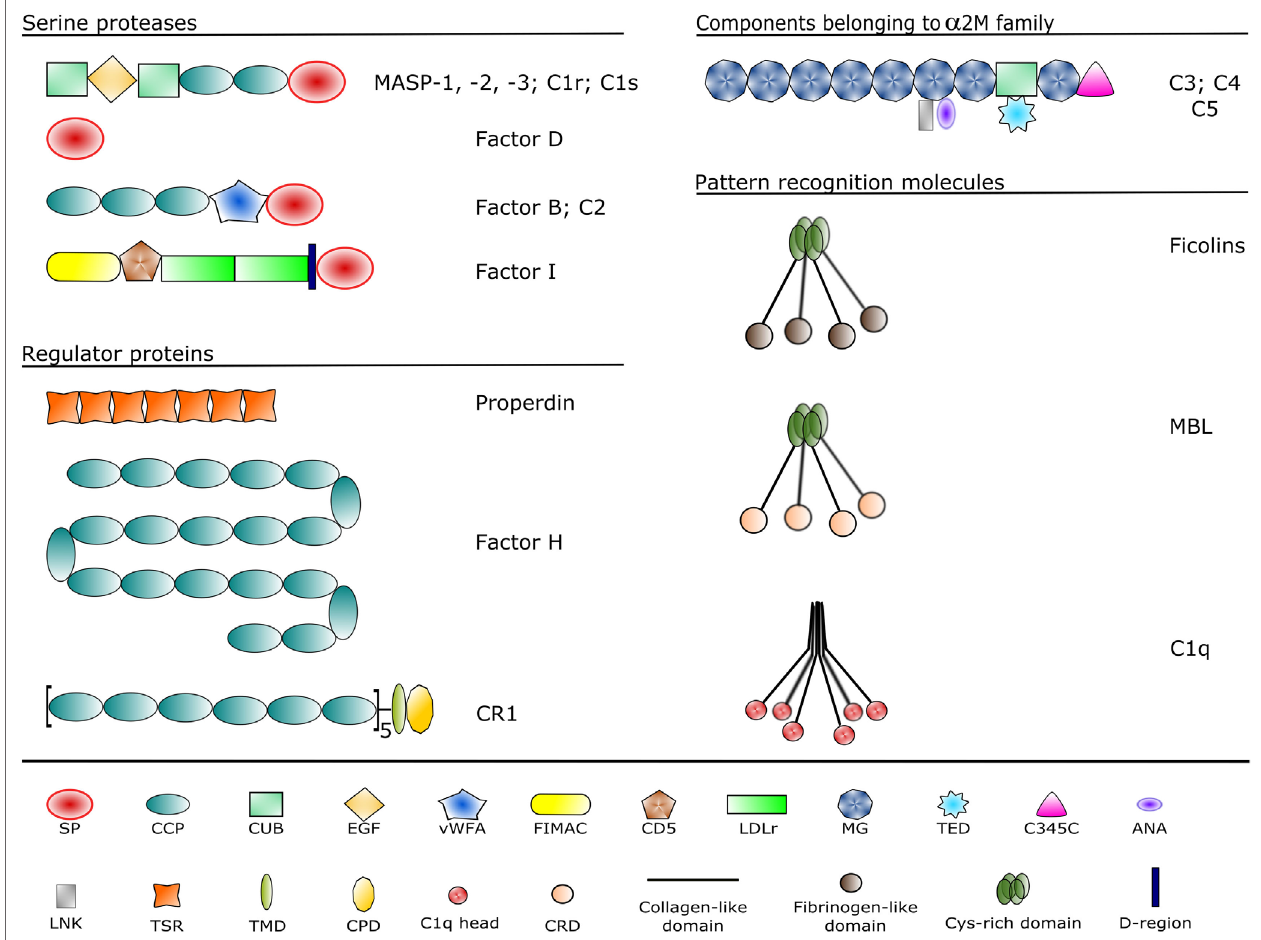
FiGURe 2 | Domain structures of the complement components discussed in the article. Each domain type is represented by a different symbol listed at the bottom. Domain abbreviations are as follows: SP, serine protease; CCP, complement control protein; CUB, complement C1r/C1s, sea urchin Uegf and bone morphogenetic protein-1; EGF, epidermal growth factor-like; vWFA, von Willebrand factor type A; FIMAC, factor I/membrane attack complex; CD5, scavenger receptor cysteine-rich domain; LDLr, low-density lipoprotein receptor; MG, α -macroglobulin; TED, thioester domain; ANA, anaphylatoxin; LNK, linker; TSR, thrombospondin-type 1 repeat; TMD, transmembrane domain; CPD, cytoplasmic domain; CRD, carbohydrate recognition